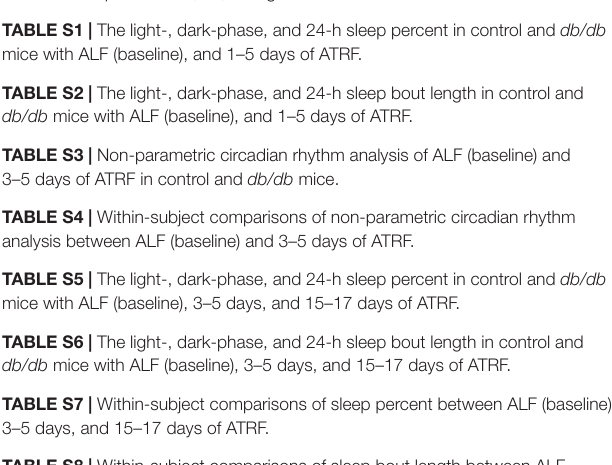
FIGURE S1 | The sleep-wake profiles in the control and db/db mice with ALF and 1–5 days of ATRF. The sleep-wake profiles with 95% confidence interval in the control (A) and db/db (B) mice. The gray box indicates the dark-phase. FIGURE S2 | Lomb-Scargle Periodogram of the control and db/db mice with ALF and 3–5 days of ATRF. (A–D) Individual mouse periodogram of the control mice with ALF (A) or ATRF (C) and db/db mice with ALF (B) or ATRF (D) . (E) The amplitude of the peak period length. (F) The sum amplitude of period length less than 6 h. ∗∗∗∗ p < 0.0001; ns , no